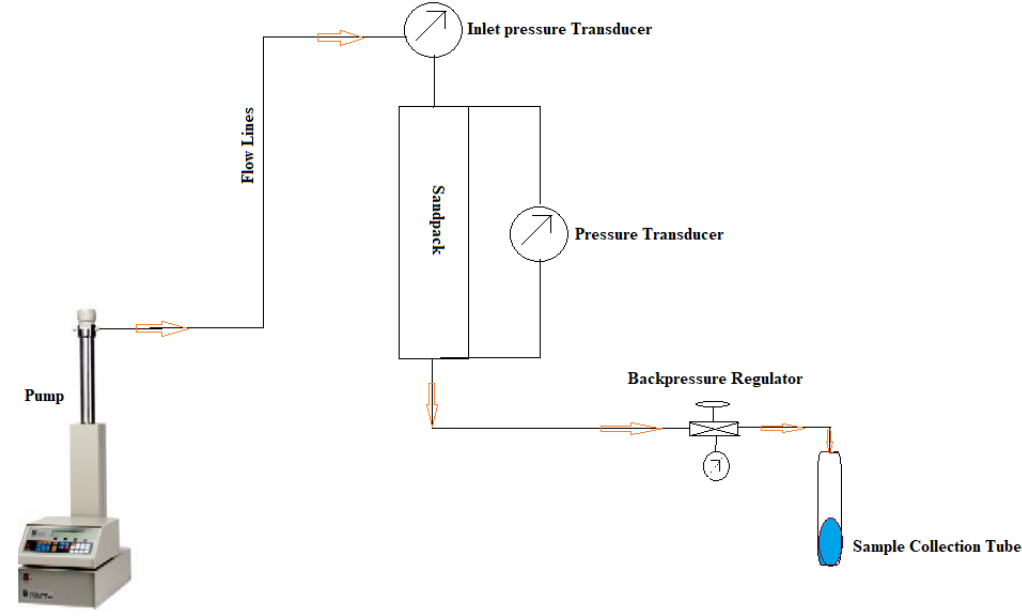
Figure 1. Schematic of the sandpack flooding setup.